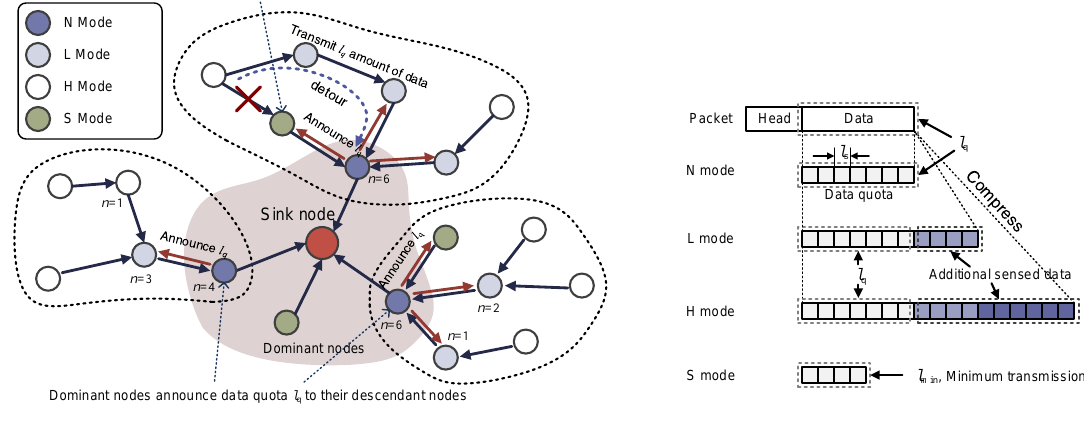
Figure 1. Overview of the proposed